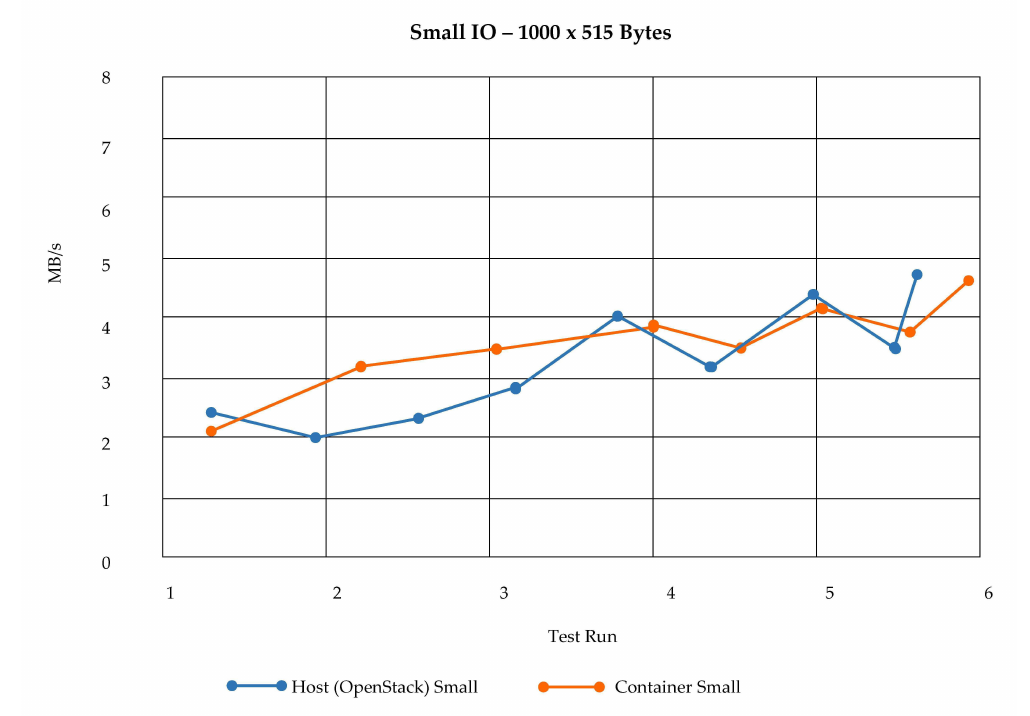
Figure 29. Container usage in Small Host